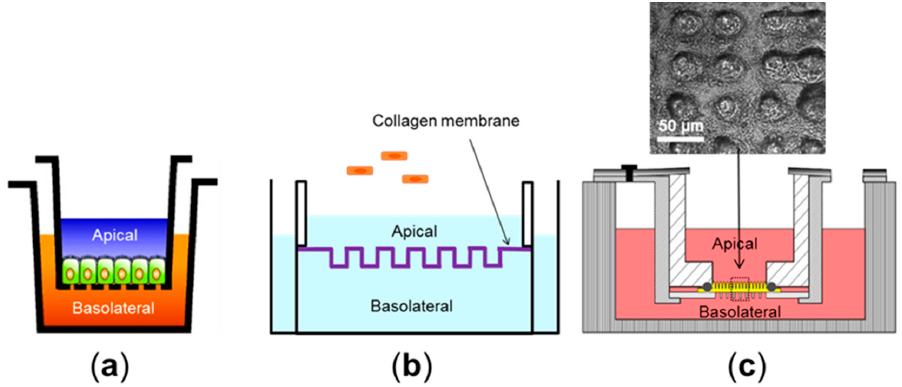
Figure 1. Schematics of static culture models using human intestinal epithelial cells: ( a ) an